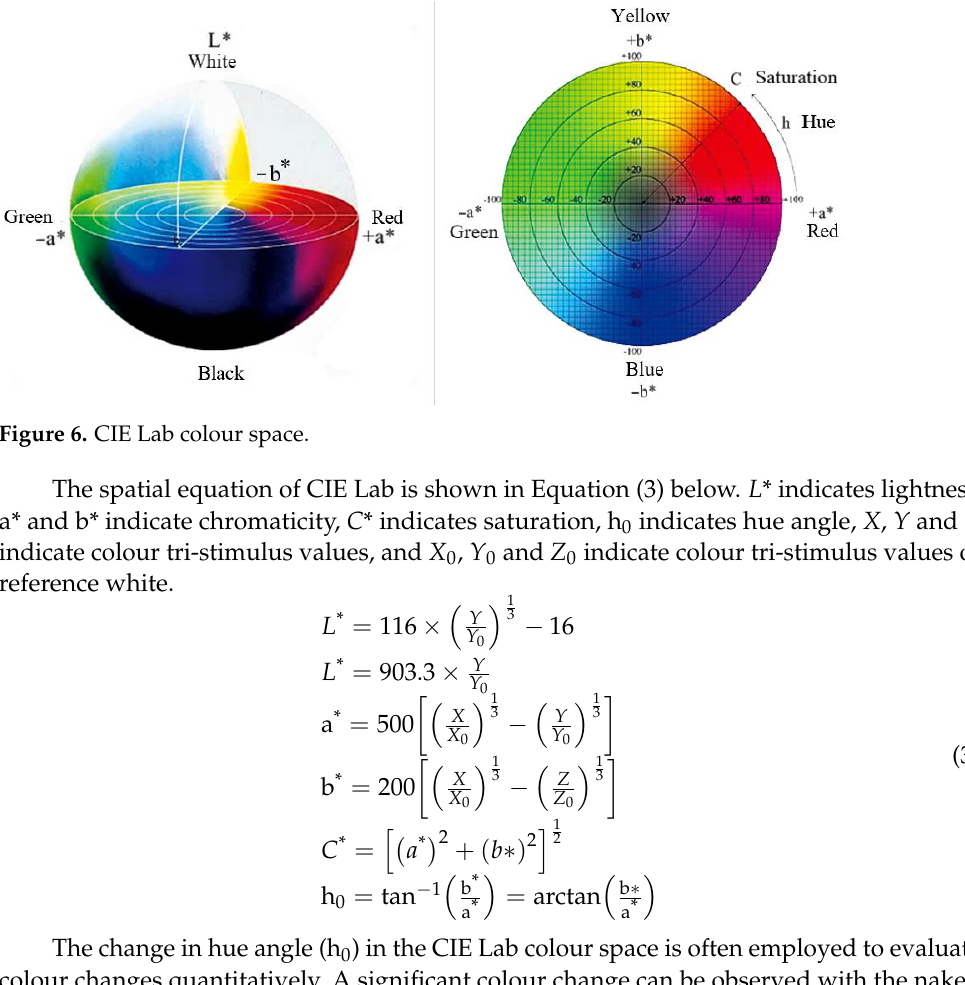
8 of 12 Table 3. CIE chromaticity coordinates of samples. Sample